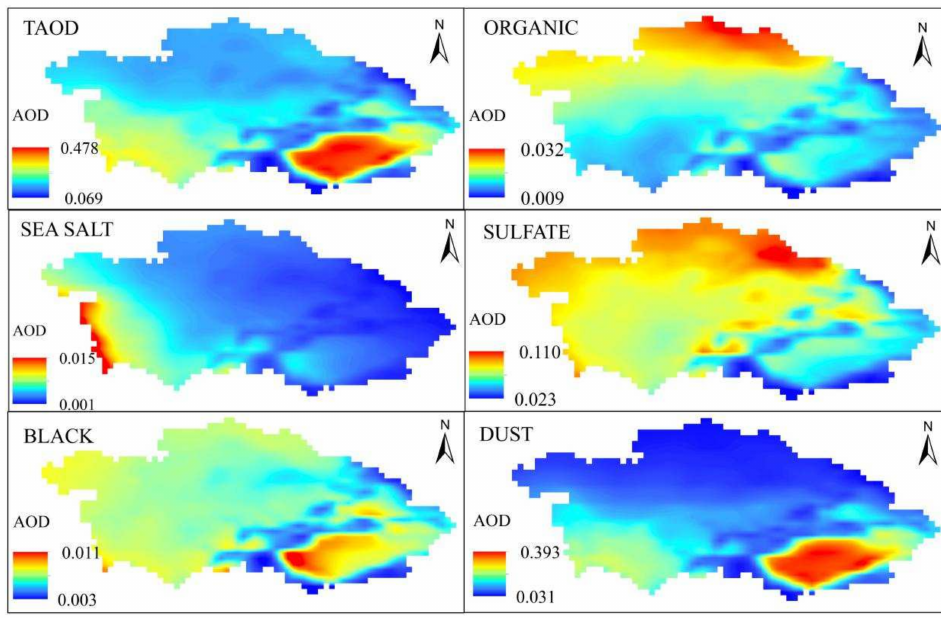
Figure 4. Average distribution of different types of aerosols in MERRA-2 from 2001 to 2020. Aerosol parameters supported the fact that coarse particles were present in consider- able amounts during summer and autumn (influence of natural emissions of dust), whereas fine particles were present during winter (influence of anthropogenic emissions)